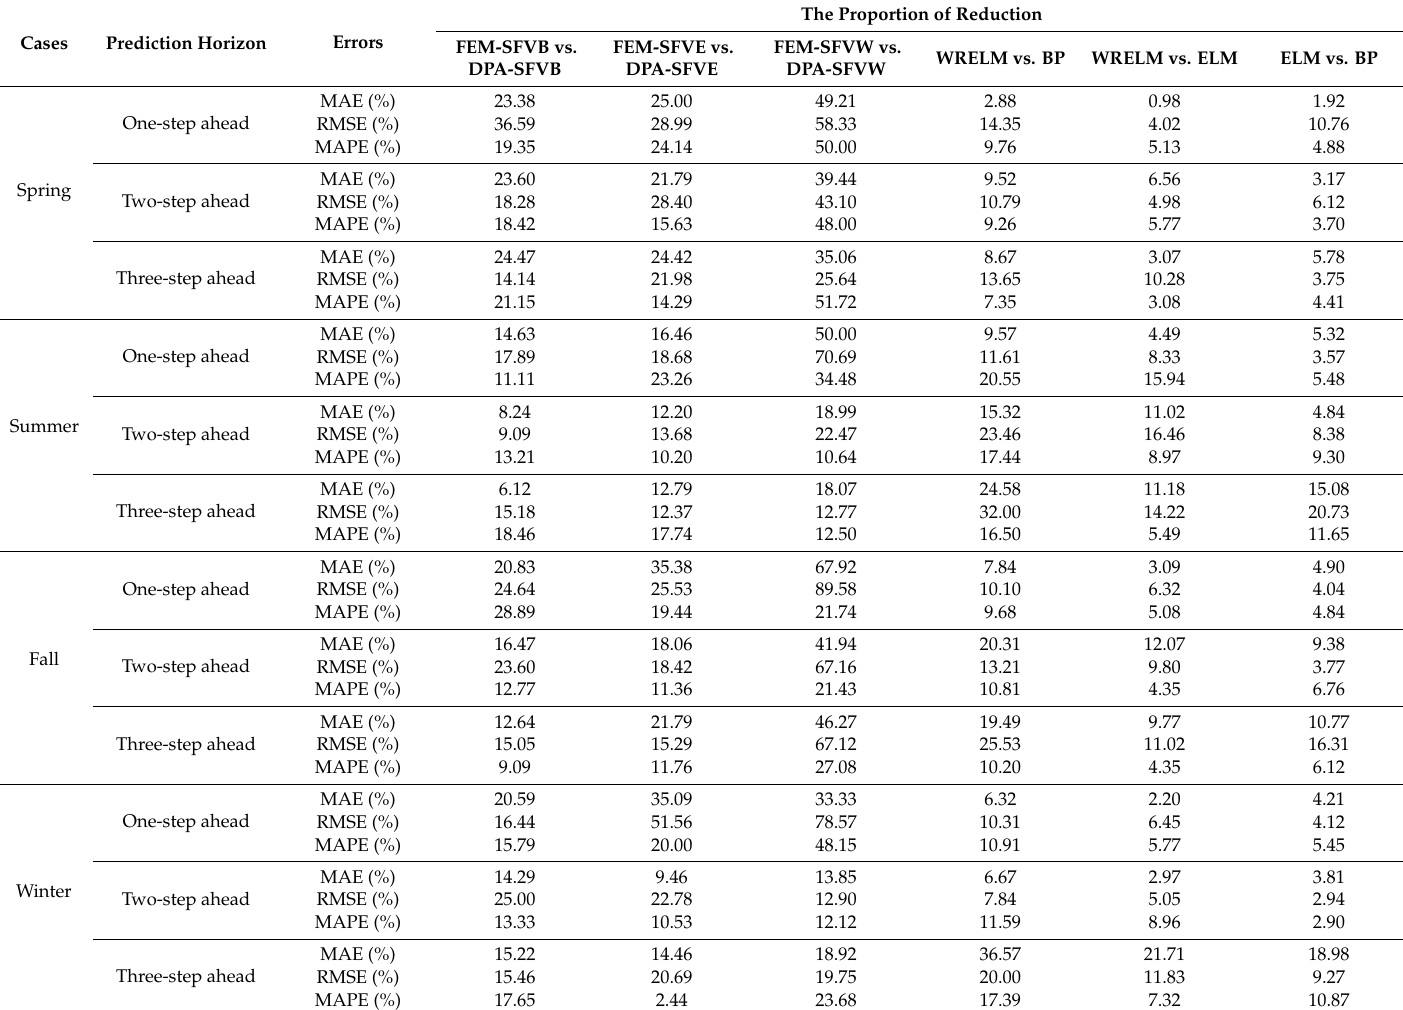
Table 10. Comparison results of experiment I and experiment II in four